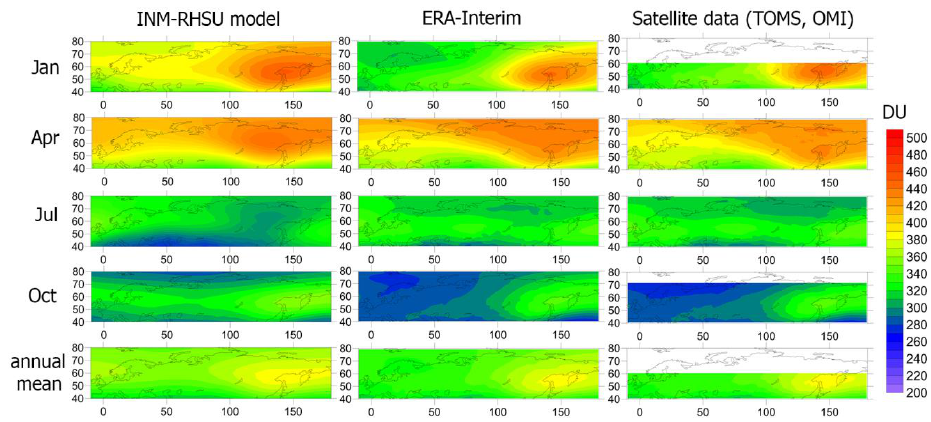
Figure 3. Climatology of the total ozone content (in Dobson units) over 1979–2015 according to the INM-RSHU CCM, ERA-Interim reanalysis, and TOMS / OMI satellite data. X -axis—is longitude, Y -axis—is latitude. Table 1. Main statistics of total ozone column X (DU) and cloud modification factor CMFuv over Northern Eurasia for the 1979–2015 period *. Year Total Ozone Column, X, DU Mean ± confidence interval at p =